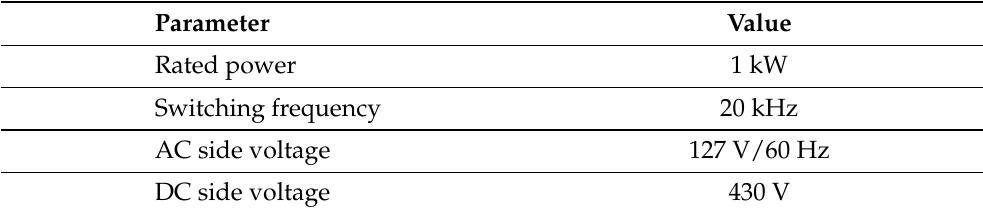
Table 2. Converter specifications for experimental results (single-phase).